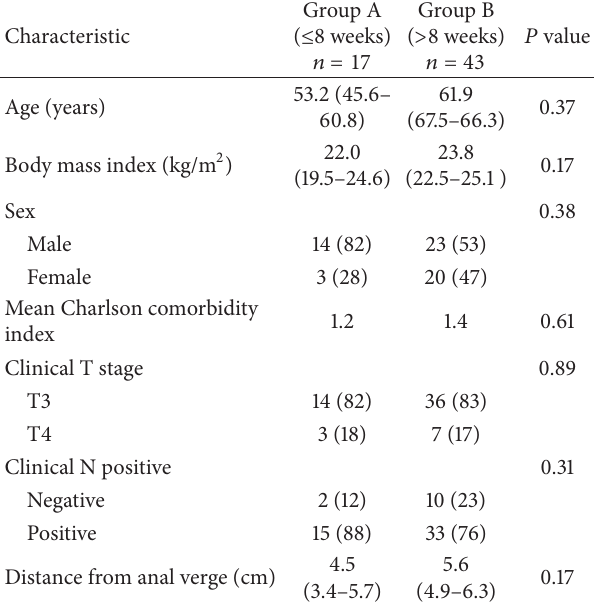
Table 1: Demographic